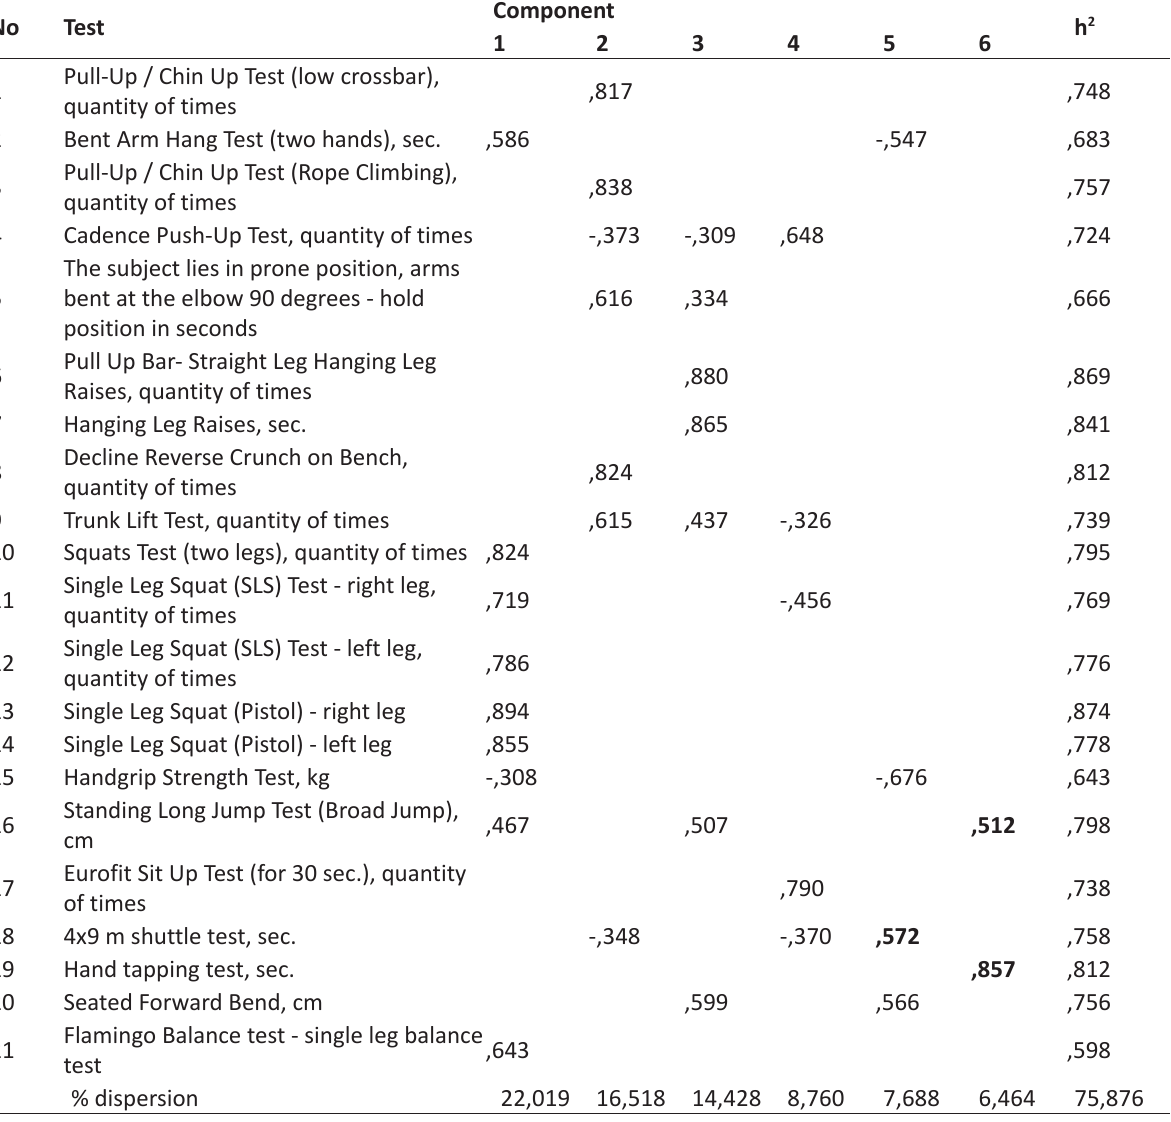
Table 2. Factor structure of motor preparedness of the girls 13 years old. Method: principal component analysis. Rotation method: Varimax with Kaiser Normalization (n =